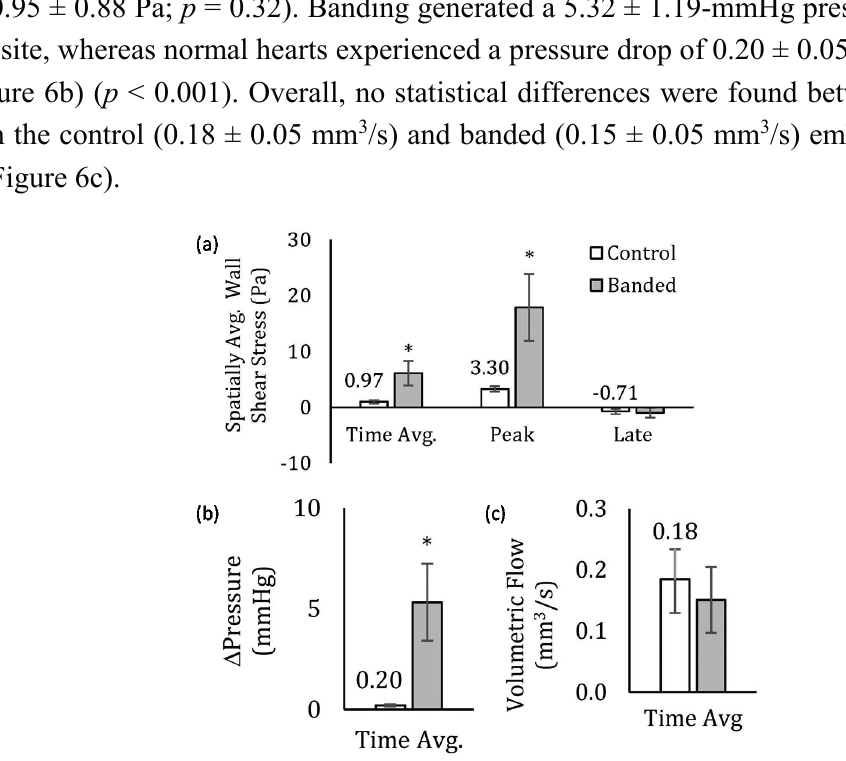
Figure 6. Hemodynamic variables, including ( a ) the spatially-averaged wall shear stress at the time-averaged flow condition, during peak flow conditions and late in the cardiac cycle during retrograde flow, ( b ) time-averaged pressure gradient and ( c ) the volumetric flow rate. * p <